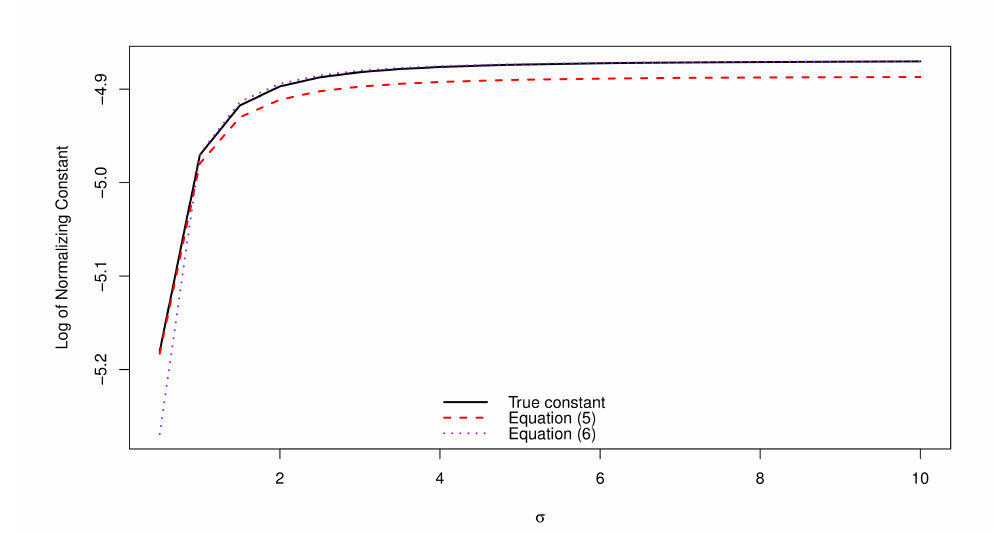
Figure 1. Approximation accuracy comparison. The exact C is the black solid line, the GVA as in (5) is the dashed red line, and the GVA as in (6) is a dotted purple